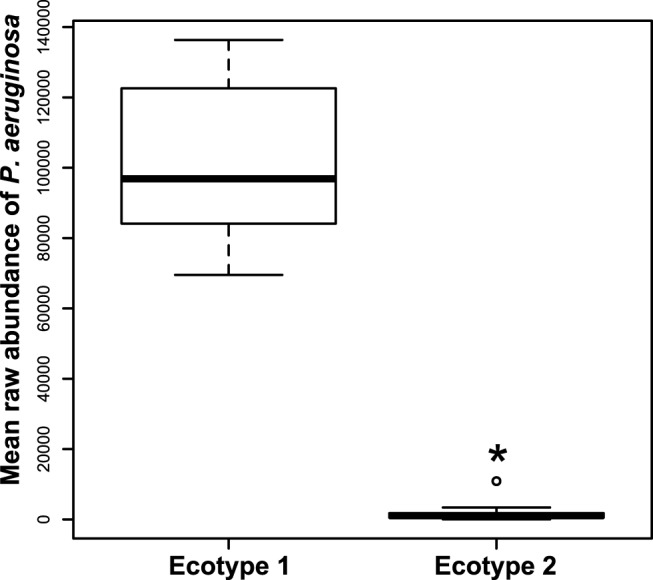
Differential mean raw abundance of Pseudomonas aeruginosa between the two ecotypes of sputum samples.Mean raw abundance of Pseudomonas aeruginosa in sputum samples from both ecotypes are represented by the raw numbers of reads in the sample. Statistical differences were assessed by a Wilcoxon test.